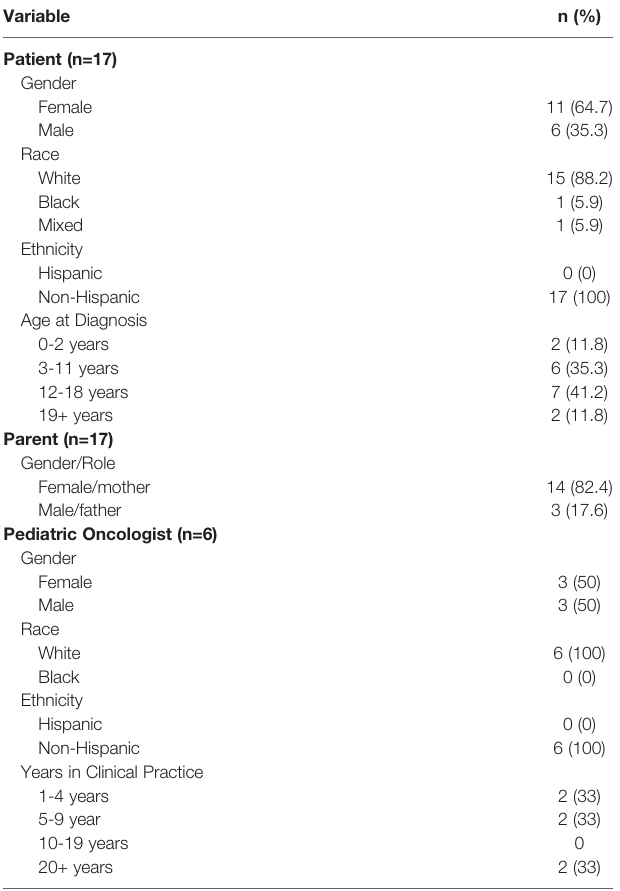
TABLE 3 | Participating patient, parent, and oncologist characteristics.